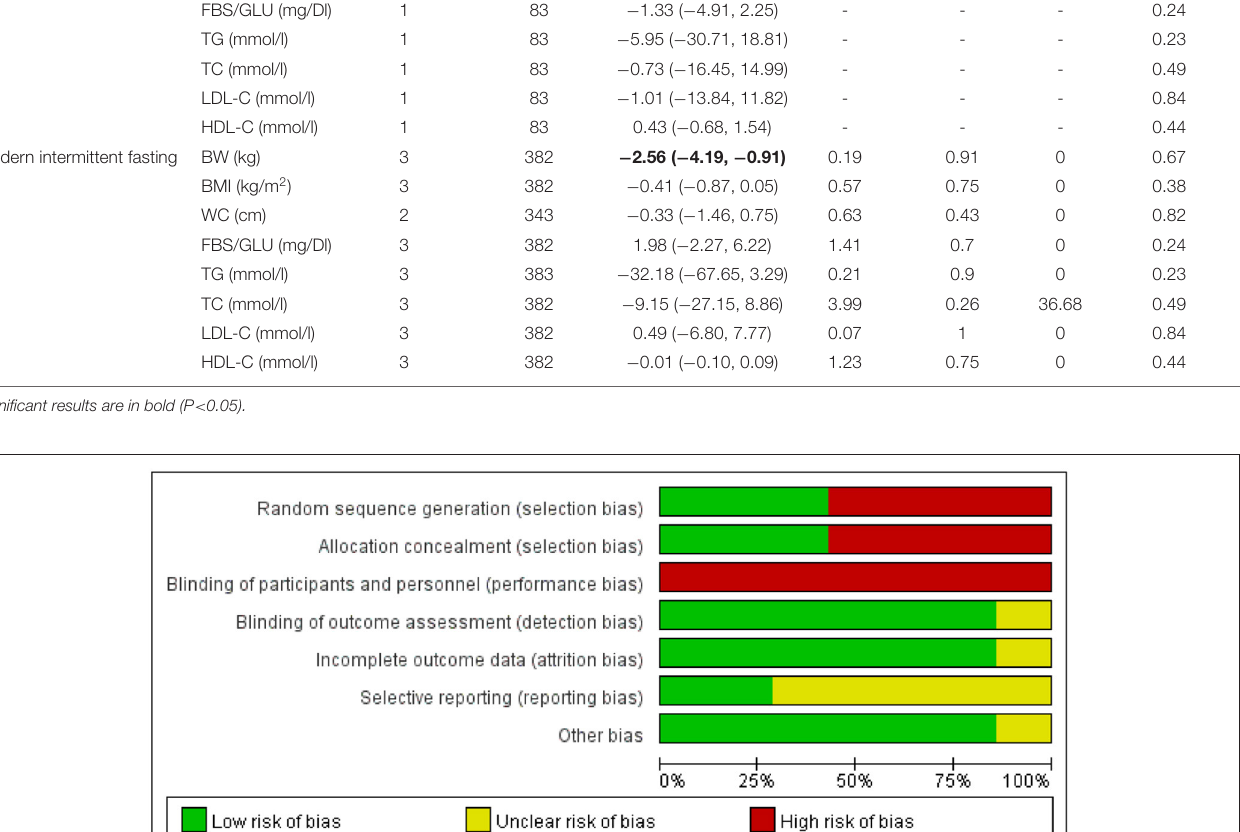
Frontiers in Nutrition |